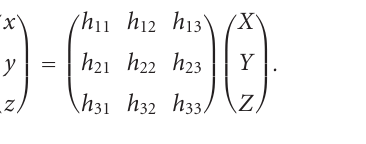
Table 1: The detection results for human activity recognition in home-care monitoring. In kitchen Sitting on couch Playing piano To balcony In bedroom In bathroom dining